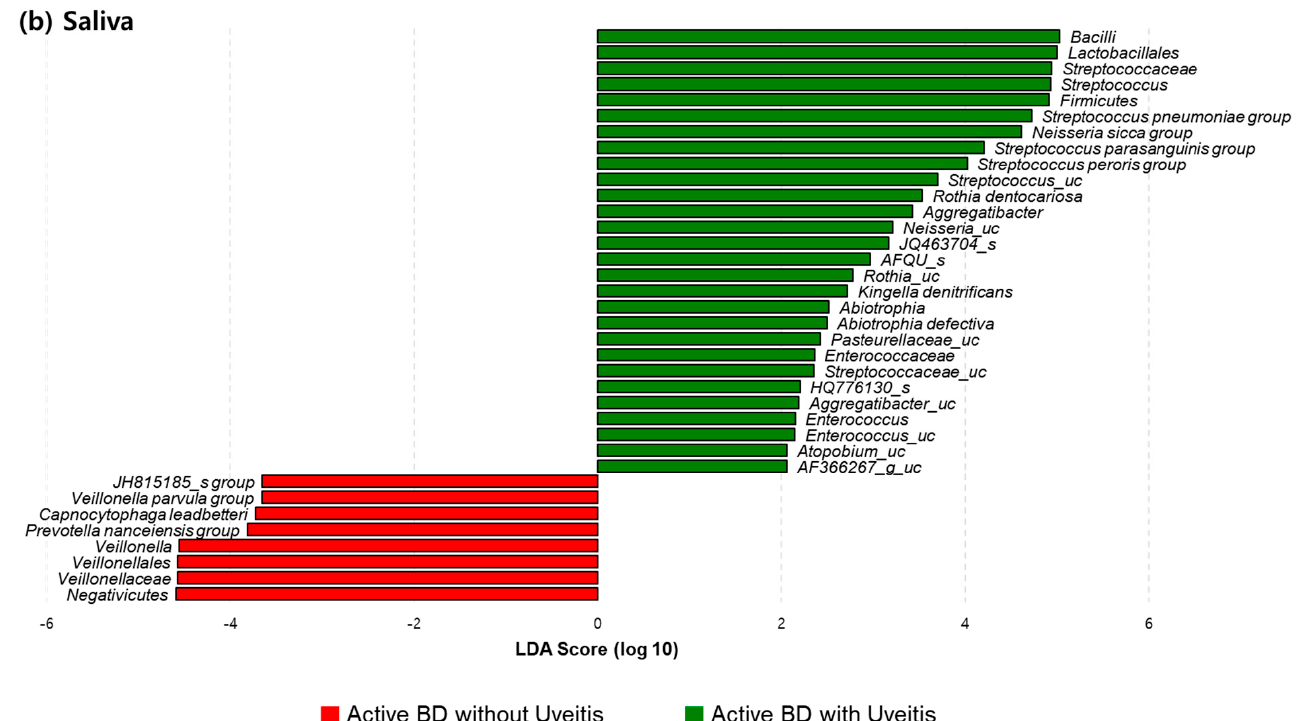
Figure 9. Relative abundances of taxonomic compositions of microbiomes of stool ( a ) and saliva ( b ) in active BD with uveitis (green) and active BD without uveitis (red) groups. The linear discriminant analysis (LDA) scores (log 10) were calculated using the LDA Effect Size (LEfSe) algorithm. The various taxa showed a LDA score (log 10) of more than 4 in the stool and saliva of both groups. BD, Behçet’s disease.